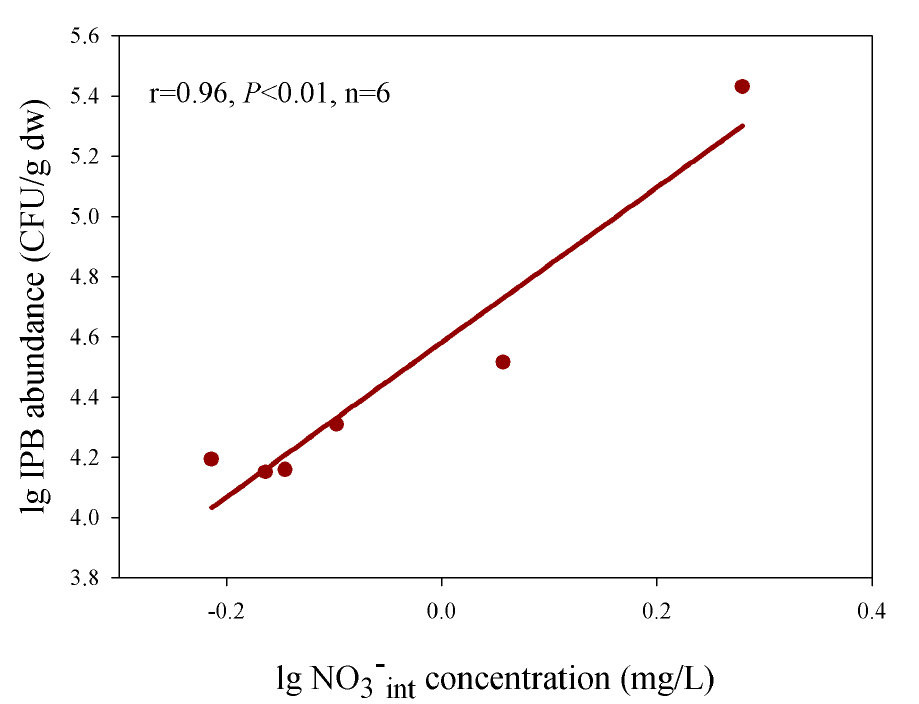
Figure 7. Correlation between sediment IPB abundance and NO 3 − concentration in interstitial